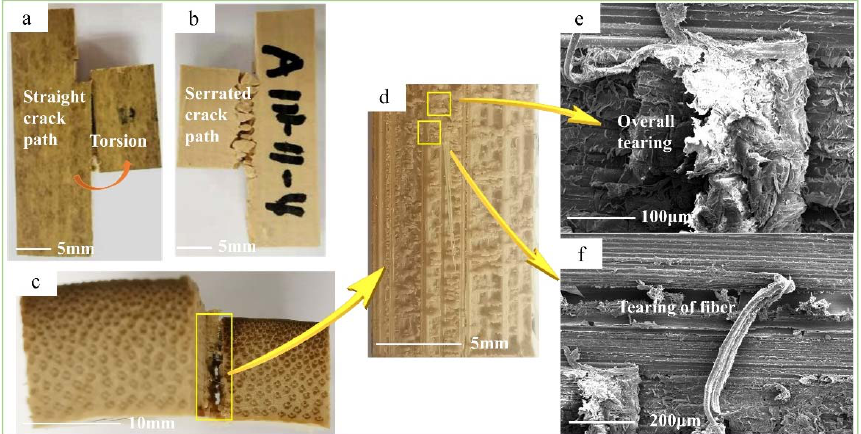
Polymers 2022 , 14 , x Figure 6. Shear-failure characteristics of step-shear method: ( a ) straight crack path at outer surface; ( b ) serrated crack path at inner surface; ( c ) Top view of failure specimen; ( d ) Shear failure surface; ( e ) SEM image of the overall tearing parenchyma cells; ( f ) SEM image of fiber tearing.